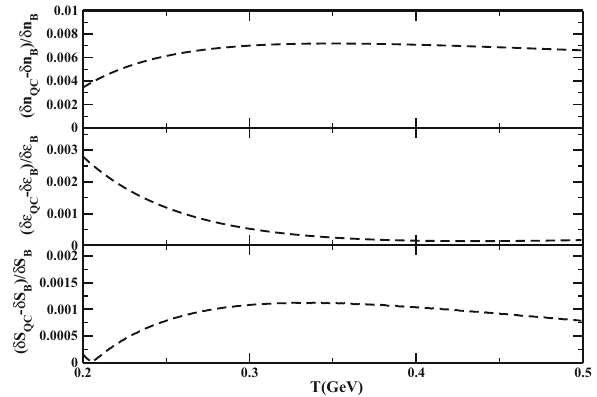
Fig. 4 Velocity of sound as a function of the temperature in non- extensive environment